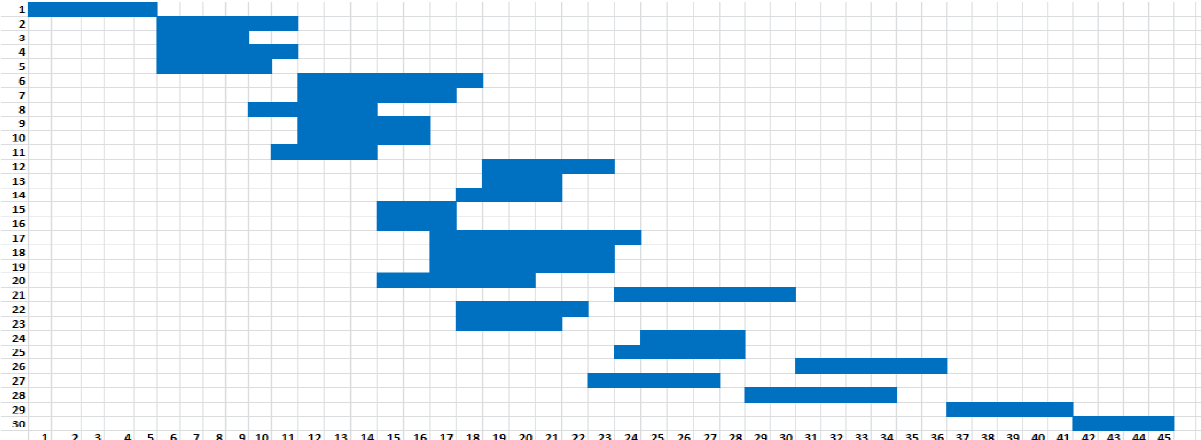
Figure 23. Gantt chart of the 8th experiment relaxed resource